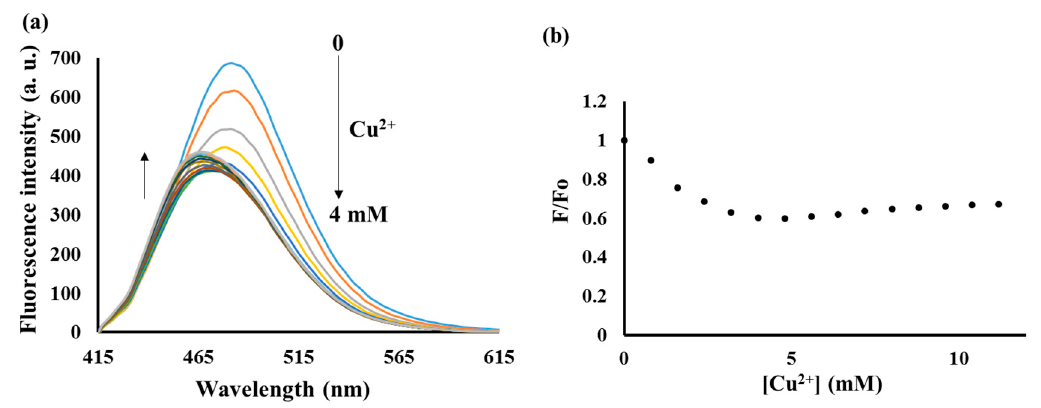
Figure 5. ( a ) Changes in the emission spectrum of P1 (7 × 10 − 5 g/L) in acetonitrile upon the addition of Cu 2+ aliquots (1.25 × 10 − 3 M); ( b ) plots of F/F o against [Cu 2+ ]. Excitation was performed at 395 nm.